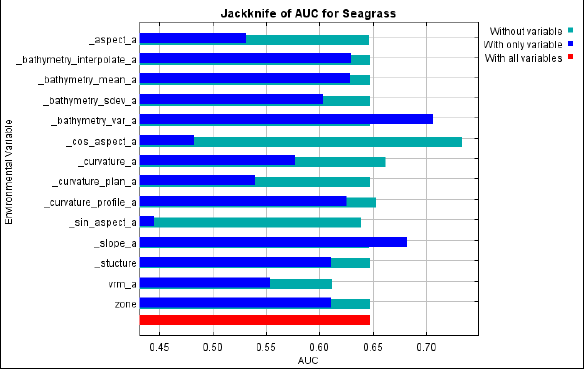
Figure 7. The Jackknife test for variable importance, expressed as AUC for seagrass habitat suitability model using each variable. Figure 10. Response curves of Vector Ruggedness Measure (VRM) for the seagrass habitat suitability model.